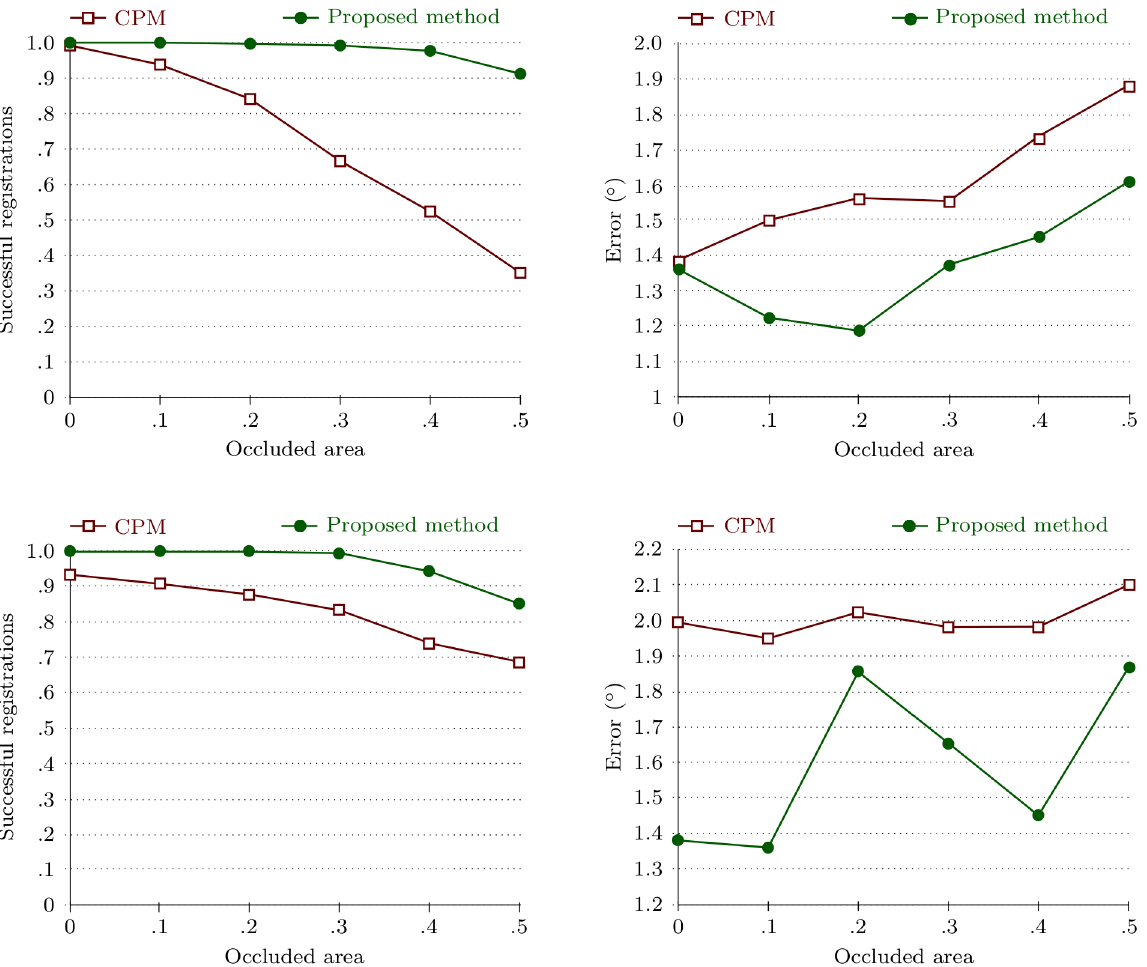
Figure 13. Robustness (left column) and accuracy (right column) evaluation, performed on synthetically degraded images. Results for first and second synthetically degraded datasets are presented in the first and second row respectively.